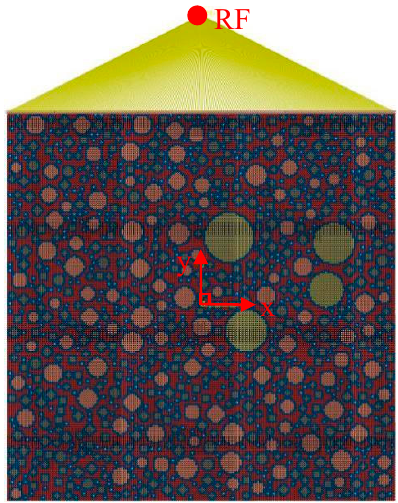
Figure 8. 2D RCA model with coupling constraints.